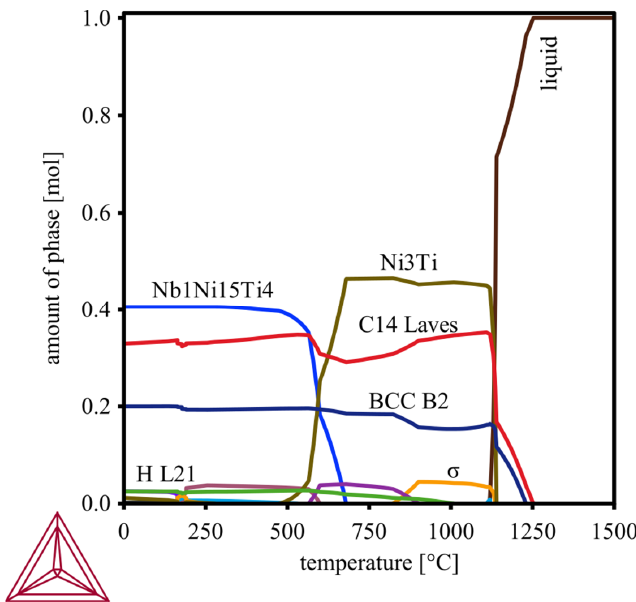
Figure 12. Phases and phase fractions (in mol) plotted over the temperature range 0 °C to 1500 °C for the CrFeNiTi MPEA, according to the Thermocalc